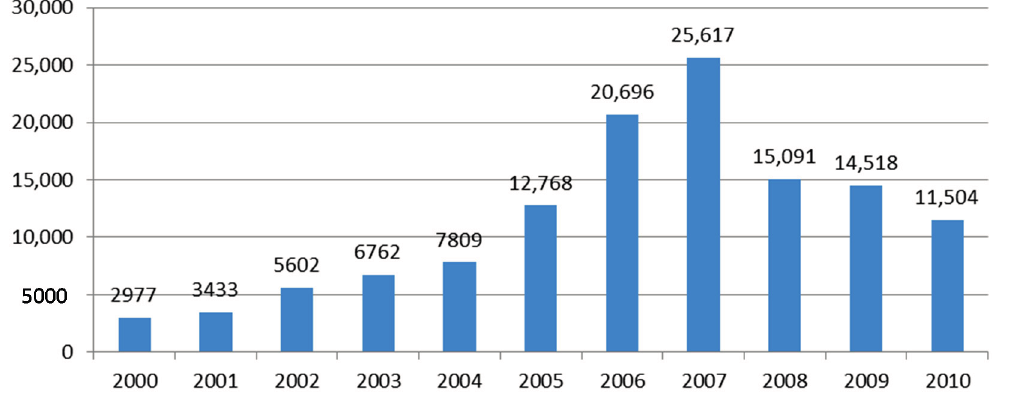
Figure 5. Dynamics of private farms in Ferghana Province 2000–2010 (total numbers).